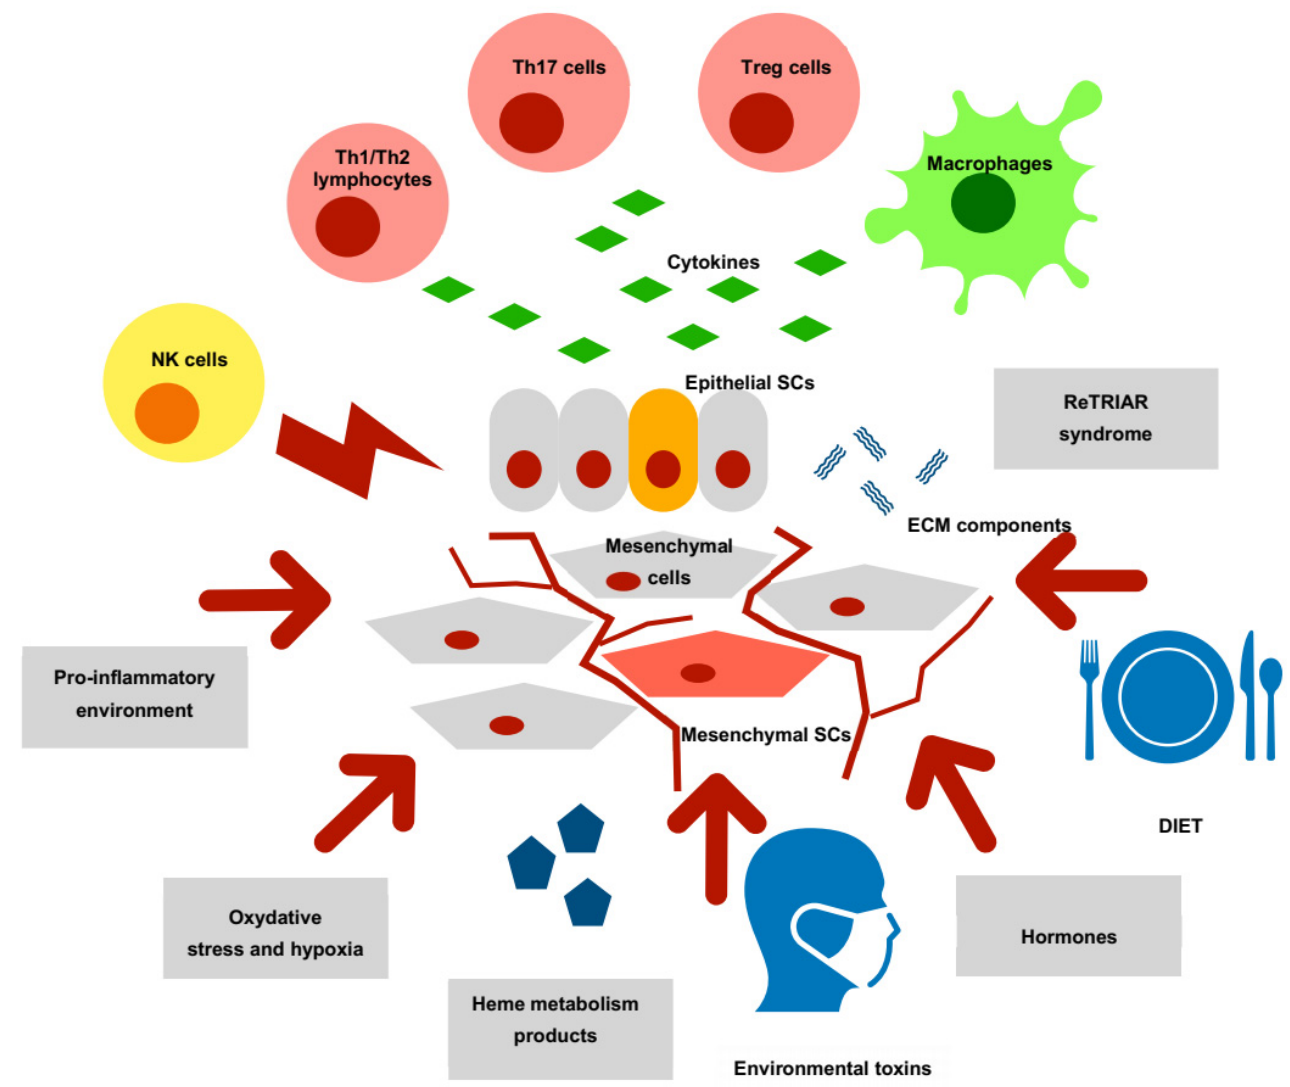
Figure 1. Niche for endometriosis epithelial stem cells Endometriosis epithelial stem cells (SCs) are regulated by several components of the endometriotic niche. Immune cells (natural killers (NK), Th1 and Th2 lymphocytes, Th17 lymphocytes, T regulatory cells (Tregs) and M1/M2 macrophages) are engaged in both elimination and supporting of endometrial lesions and their resultant action followed by secretion of cytokines and chemokines has a deep influence on survival of endometriosis epithelial SCs. Repeated injury and tissue repair (ReTRIAR) syndrome changes the ECM components and promotes fibrosis of implants. Fibrogenesis-mediated changes of gene expression, together with a pro-inflammatory environment could account for DNA damage in epithelial SCs. The mutational pressure of oxidative stress and heme metabolism products could depend on the fibrotic status of the endometriosis lesion. Oxidative stress, hypoxia and iron overload are highly mutagenic for epithelial SCs. Mesenchymal SCs are a relevant component of epithelial SCs niche. The participation of mesenchymal SCs in activin-A/ connective tissue growth factor (CTGF) pathway augments peritoneal inflammation and fibrosis in ectopic endometrial lesions. Disturbances in activin-A/CTGF pathway may be involved in carcinogenesis. Bone marrow-derived stem cells (BMDSCs) through cytokine secretion promote proliferation in endometriotic lesions. Estradiol is a hormonal mediator of mobilization of endothelial progenitor cells into endometrial implants, and in chemoattraction of BMDSCs into endometriosis implant’s stroma. Estradiol has also a stimulatory effect on inflammation and proliferation of implants. Finally, the components of diet and environmental toxins could modulate the function of endometriosis epithelial SCs.